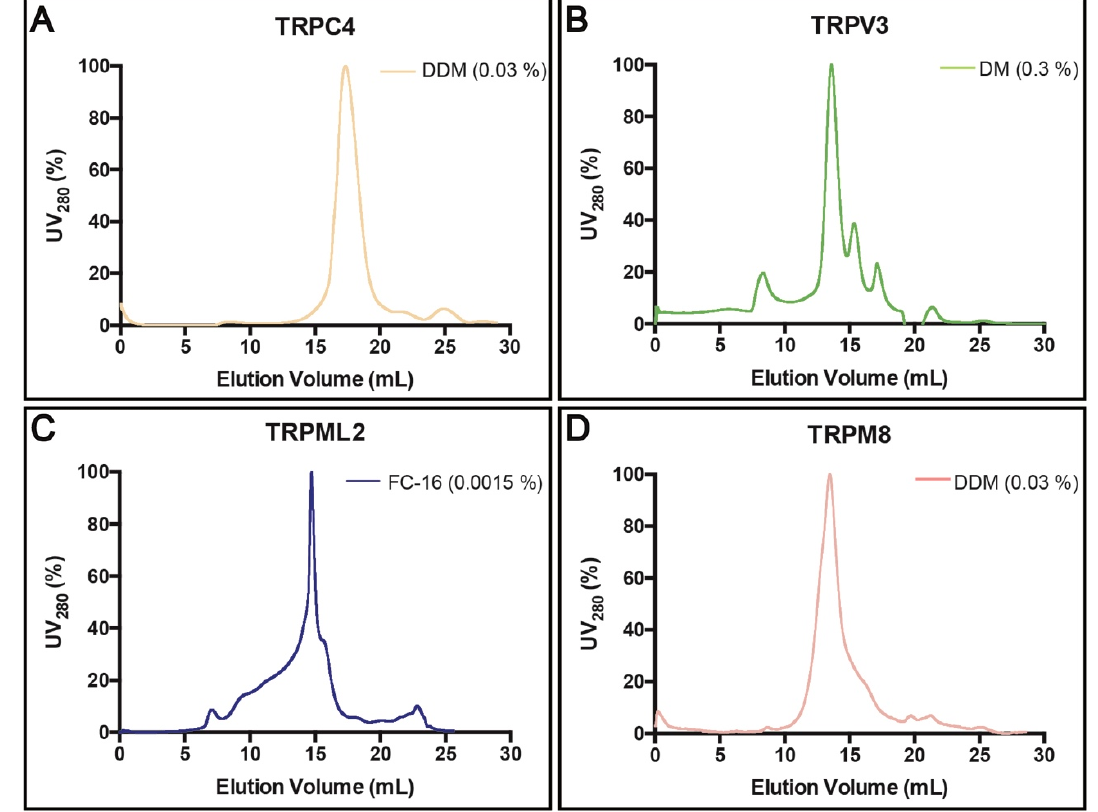
Figure 6. Size-exclusion chromatography (SEC) of selected human TRP channels. ( A – D ) Normalized SEC profiles for protein samples previously purified using reverse (TRPC4, A and TRPV3, B) or direct (TRPML2, C and TRPM8, D) affinity chromatography (immobilized metal ion affinity chromatography, IMAC). Concentrations of the corresponding detergents used during SEC are indicated. The void volume of the column (Superose 6 HR 10/30) is ~8 mL.